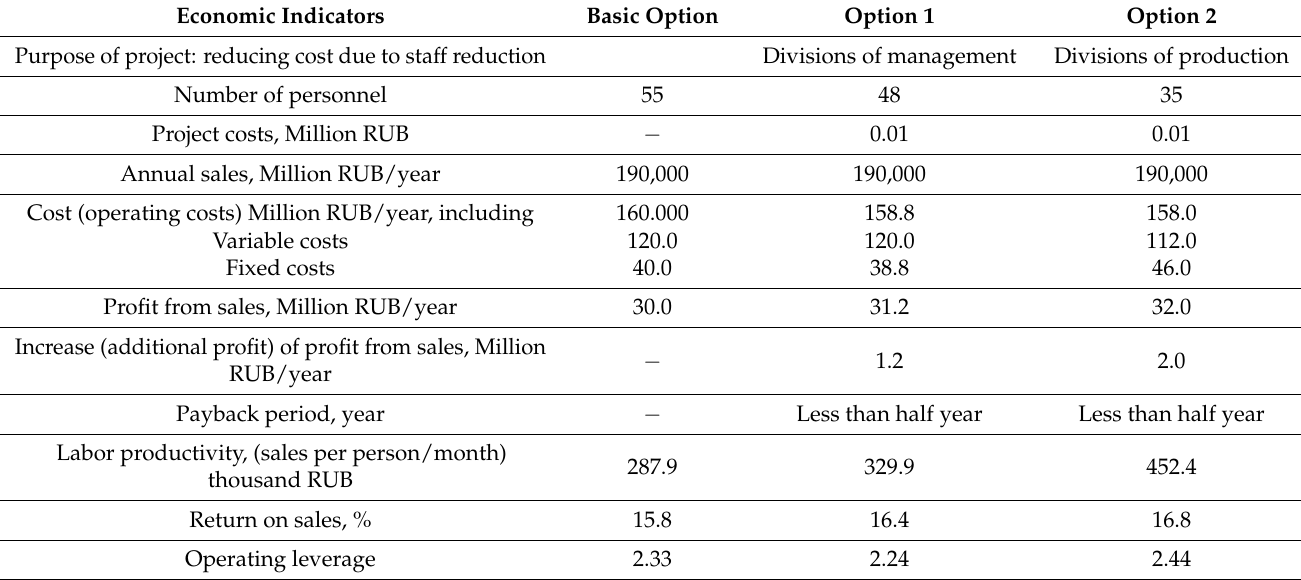
Table 4. The results of the economic assessment of HRM projects for a small innovative